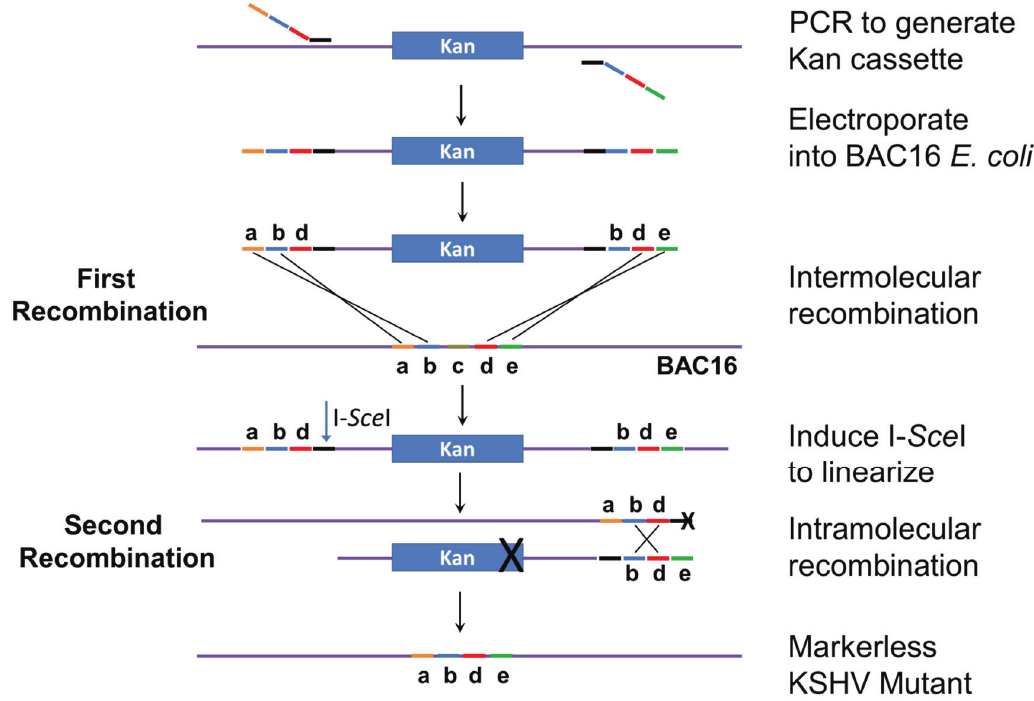
Figure 2. Two-step recombineering. Primers are designed to PCR amplify the kanamycin-resistance cassette. The primer tails match KSHV sequences ( abd for the forward primer and bde for the reverse primer). Note that sequence c will be deleted in the final construct. The PCR product is electroporated into E. coli cells carrying BAC16, and intermolecular recombination generates a kan-resistant bacmid. Induction of I- Sce I results in linearization of the bacmid. Intramolecular recombination between sequences bd near the ends of the molecule produces the final markerless KSHV mutant bacmid, with sequences abde . Modified from